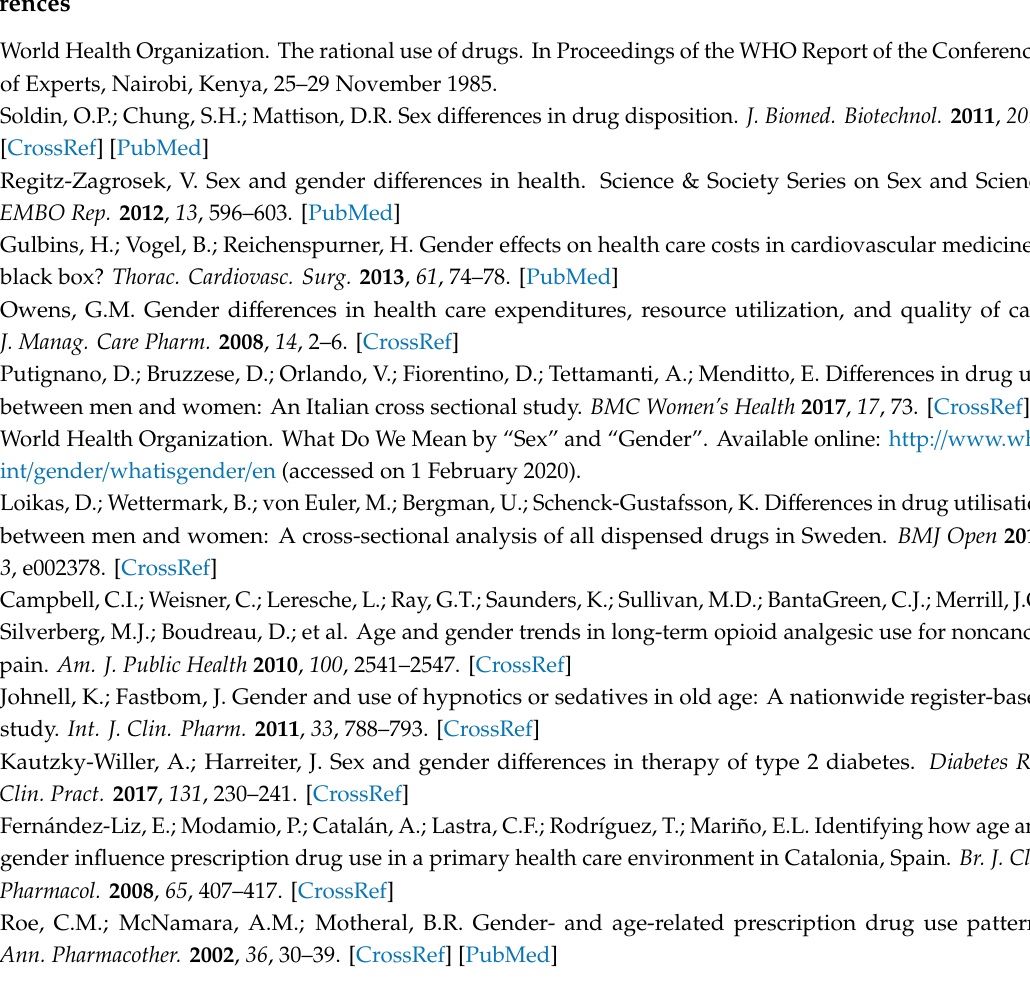
Table S1: Gender di ff erence in prevalence (%) and Risk Ratio of drug therapy (ATC IV), Table S2: Gender di ff erence in DDD / Treated and Costs / Treated of drug therapy (ATC